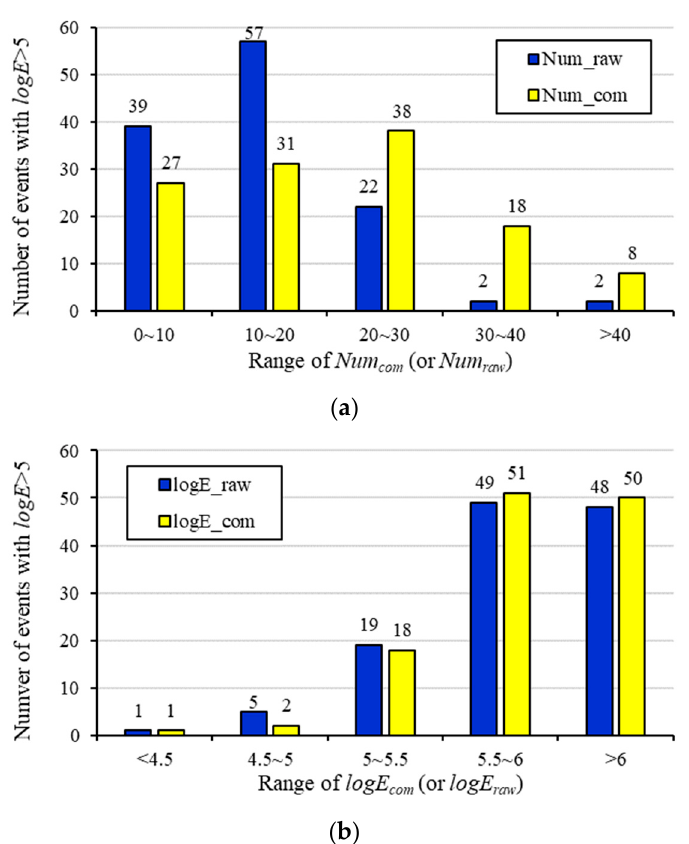
Figure 13. Number of seismic events with 𝑙𝑜𝑔𝐸 > 5 in areas with different ranges of ( a ) event counts and ( b ) energies using raw seismic data (blue columns) and compensated seismic data (yellow columns).